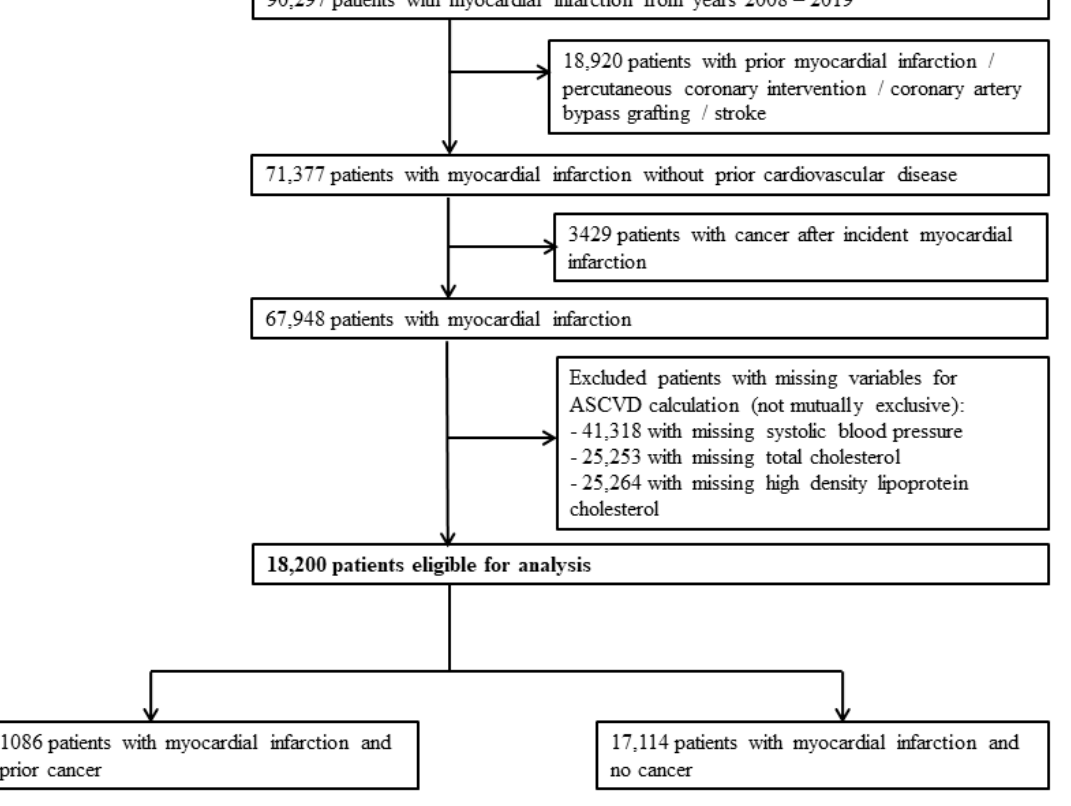
Figure 1. Study design and patient selection flow chart. Table 1. Baseline patient demographics and clinical presentation.